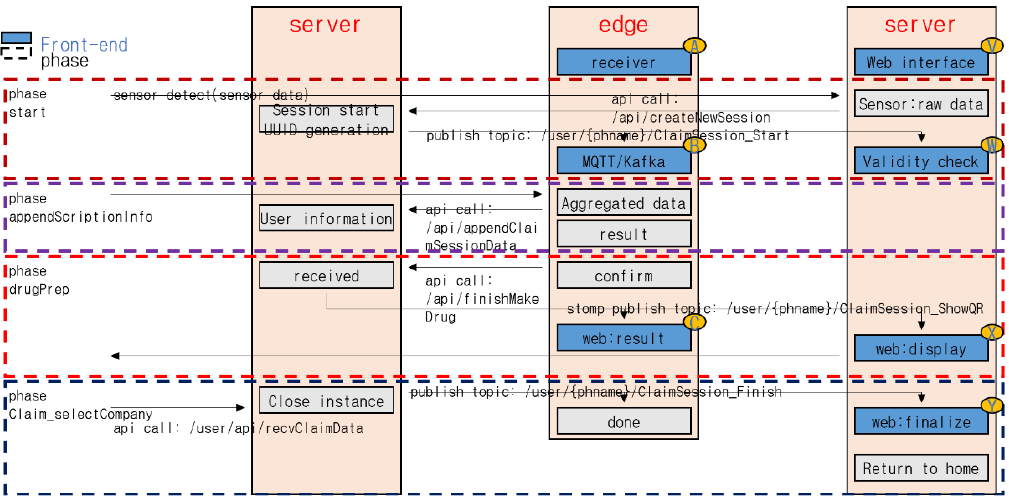
Figure 2. Operation sequence.